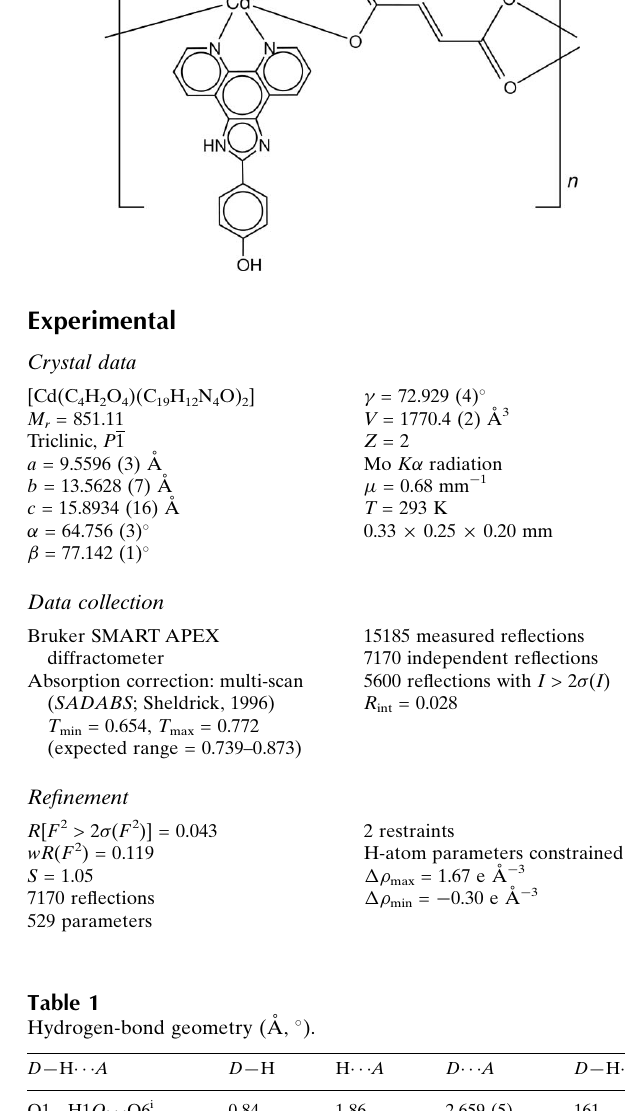
Liu (2002); Yang et al. (2007 a , b ).